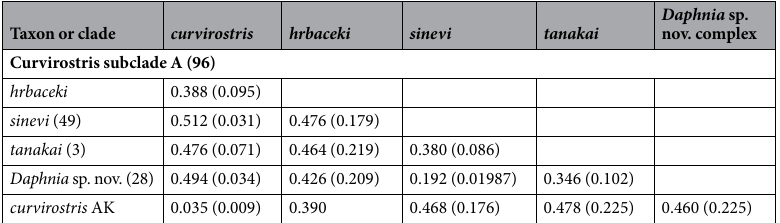
Table 1. Average number of nucleotide substitutions per site with Jukes Cantor correction (Dxy(JC)) between taxa of the Daphnia curvirostris complex. Numbers in parentheses are the standard deviations; numbers in parentheses beside taxon names are sample size. D . curvirostris from Alaska (AK) is shown separately from Palearctic